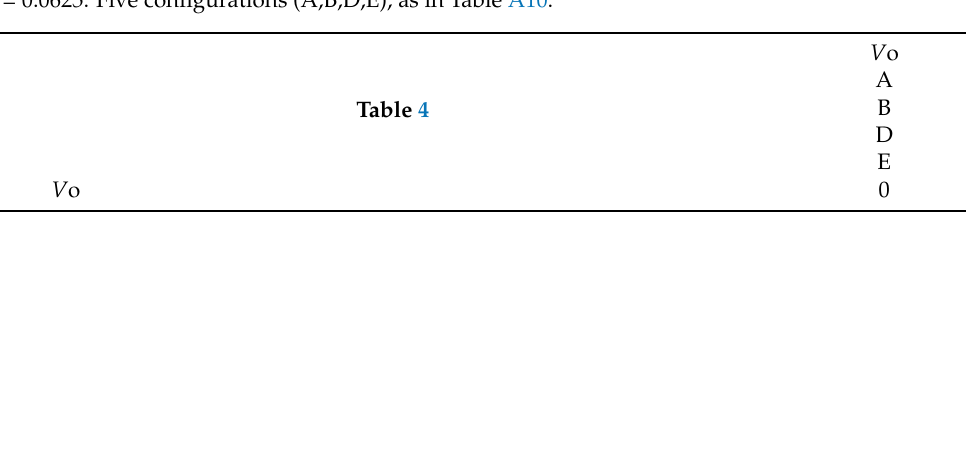
Table A8. Configurational Matrix (mutual interatomic distances in NN, as in Table A2) for x =